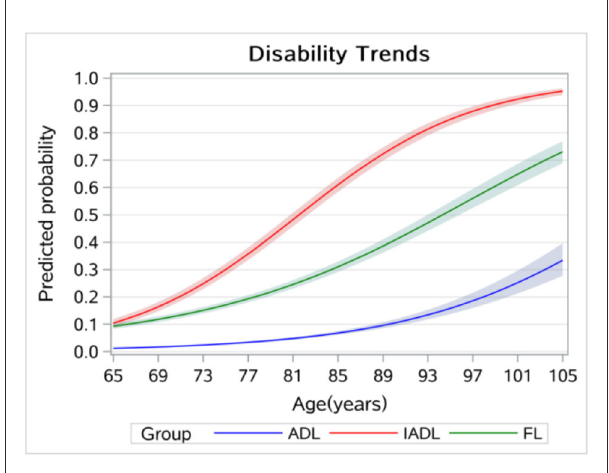
FIGURE3 Age trends in disability without controlling for cohort effects.